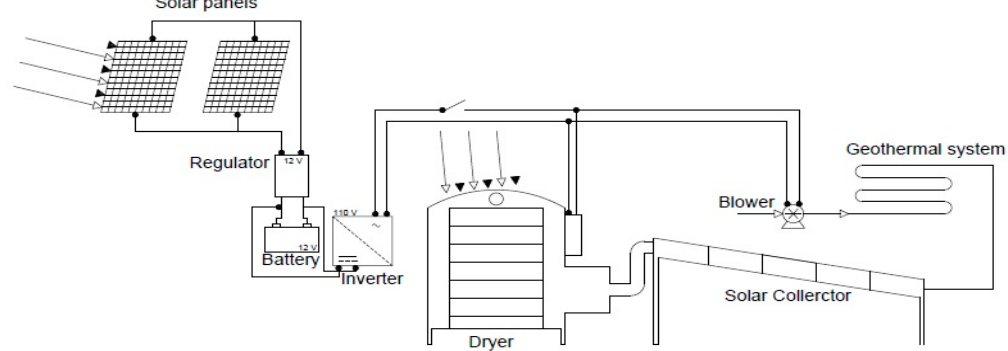
Figure 1. Scheme of the complements that are part of the hybrid dryer.